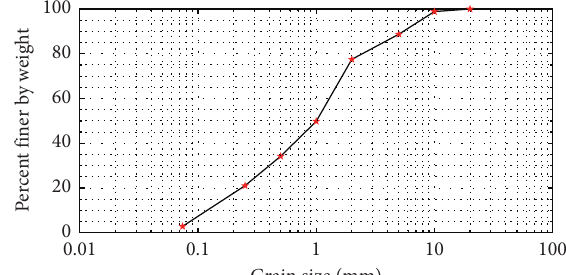
Figure 1: Curve of particle grade of subgrade